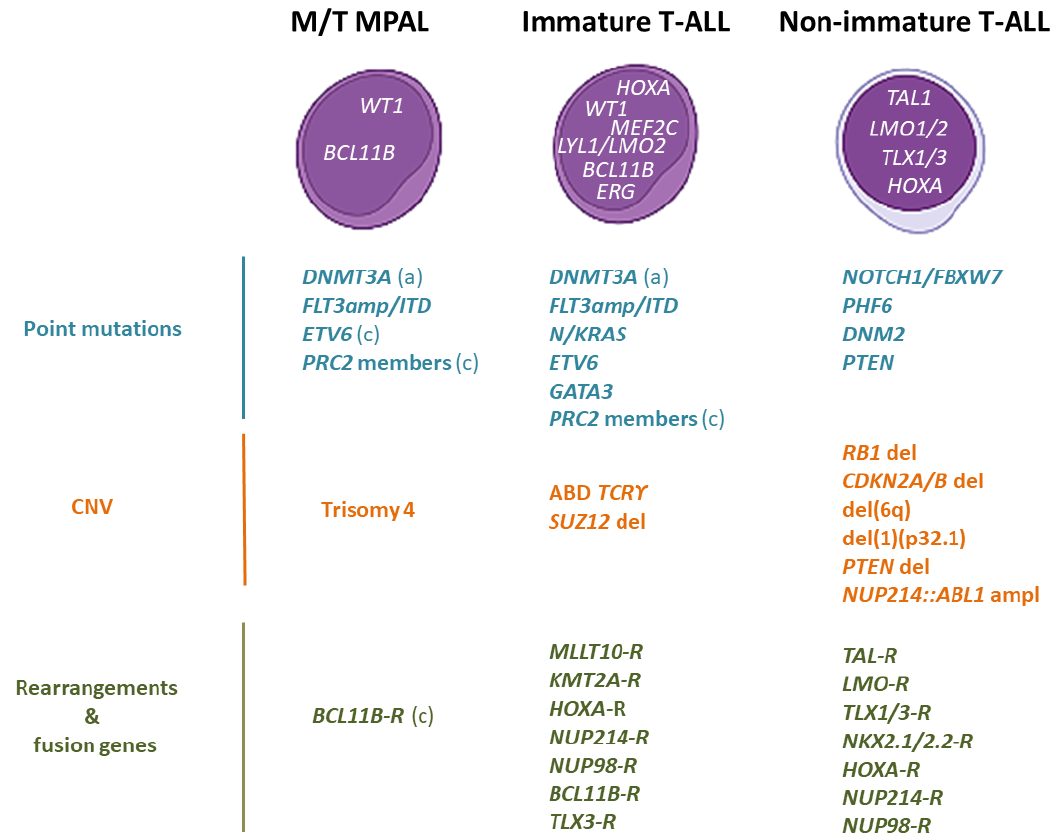
Figure 2. Differential genetic features across immature AL and non-immature T-ALL. Point mutations are identified in blue, CNV in brown, and rearrangements and fusions in dark green. The transcription factor delineating blast arrest differentiation are shown at the nucleus of each AL type. The immature AL subtypes are included within a square. (a): adult; (c) childhood; -R: promiscuous partner. Made with the help of BioRender.com, accessed on 15 February 2022.